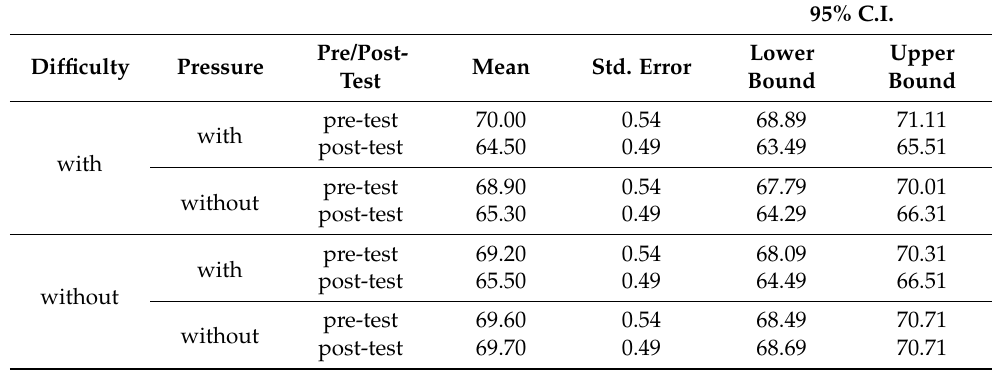
Table 22. Estimated marginal means of TMT-B—Interaction of difficulty * pressure * pre/post-test.